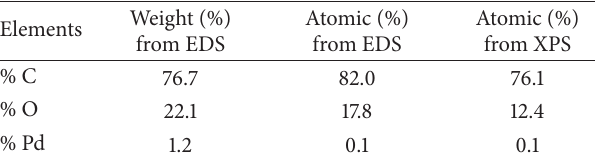
Table 1: Weight and atomic percentages obtained by EDS and XPS analysis for palladium clusters embedded in PVP produced by reduction of [PdCl 4 ] 2− at 90 ∘